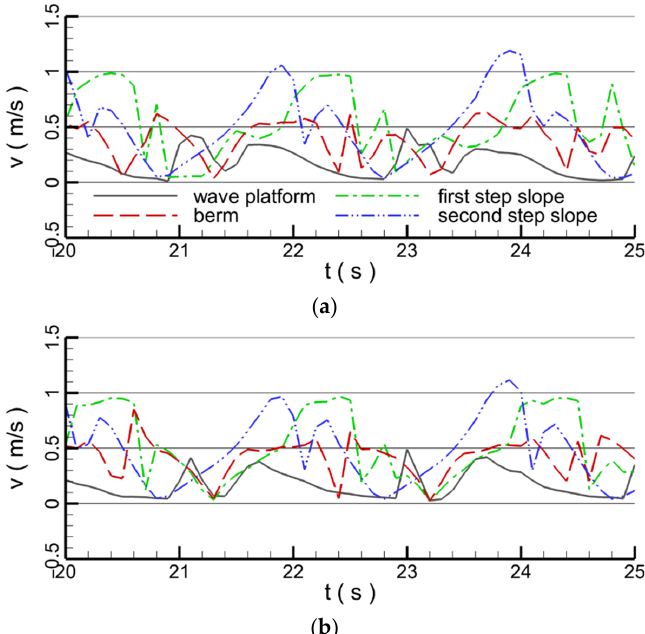
Figure 10. Velocity near the breakwater at different locations; ( a ) without fence plate; ( b ) with fence plate.